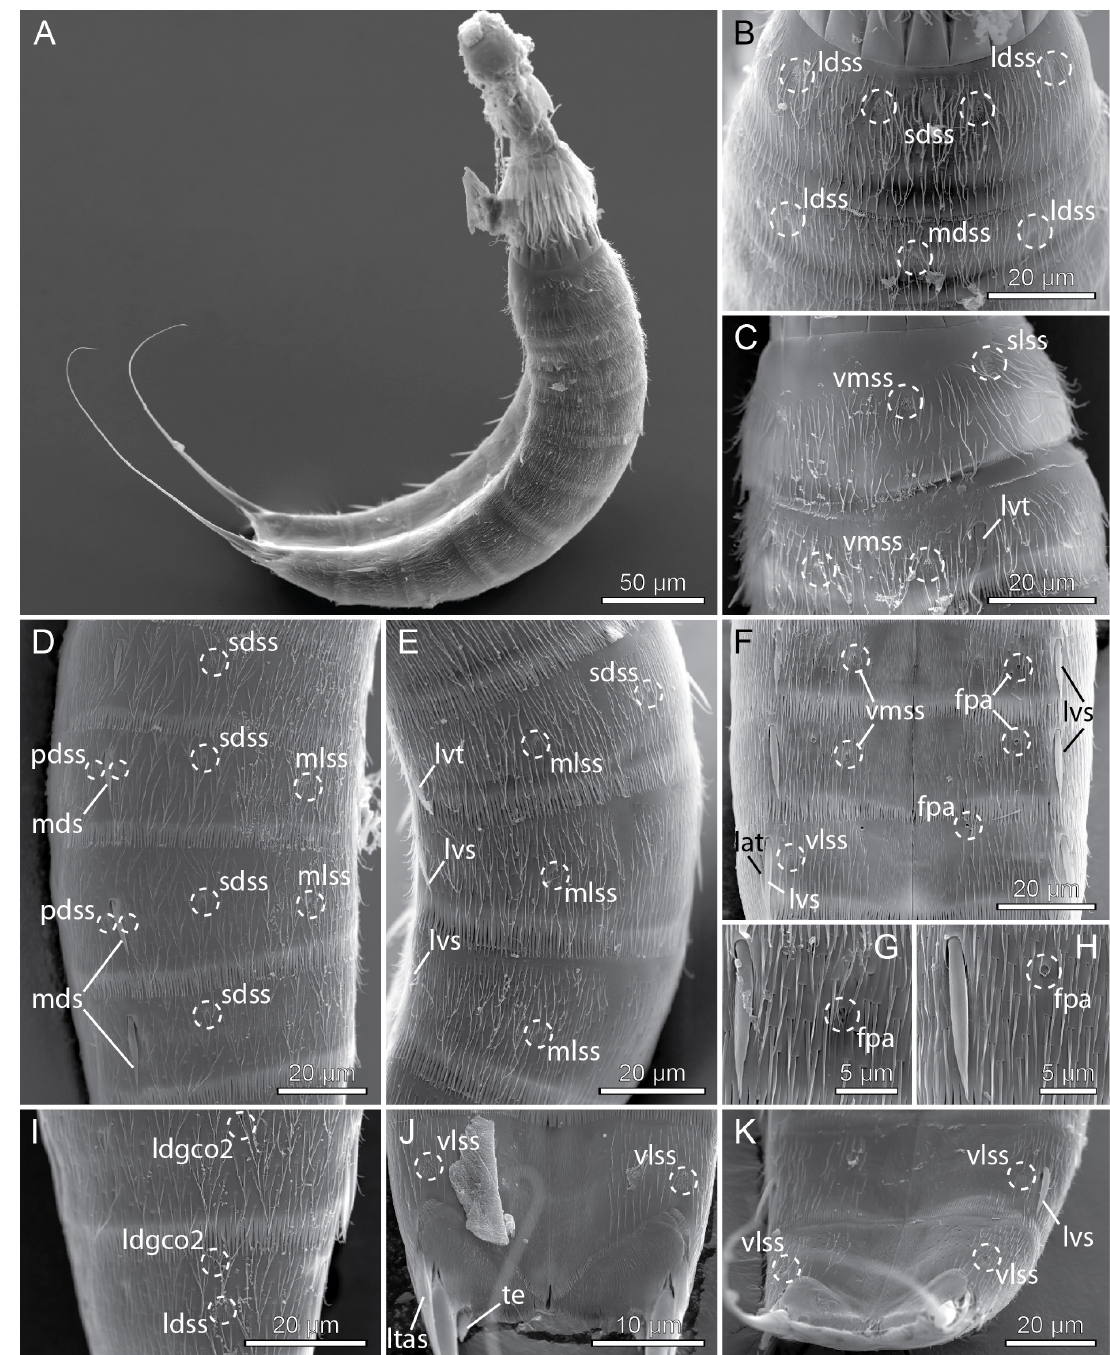
Fig. 6. Scanning electron micrographs showing overviews and details of Echinoderes gerardi Higgins, 1978. A–C, E, K . ♂ ( HY, personal reference collection). D, F–J . ♀ ( HY, personal reference collection). A . Lateral overview. B . Segments 1 to 2, dorsal view. C . Segments 1 to 2, ventrolateral view. D . Segments 5 to 8, subdorsal view. E . Segments 5 to 7, lateral view. F . Segments 6 to 8, showing female sexual dimorphism. G . Detail of segment 6 showing lateroventral spine and female papilla. H . Detail of segment 7 showing lateroventral spine and female papilla. I . Segments 8 to 9 lateral view. J . Segments 10 to 11 ventral view, showing female sexual dimorphism. K . Segments 9 to 11 ventral view, showing male sexual